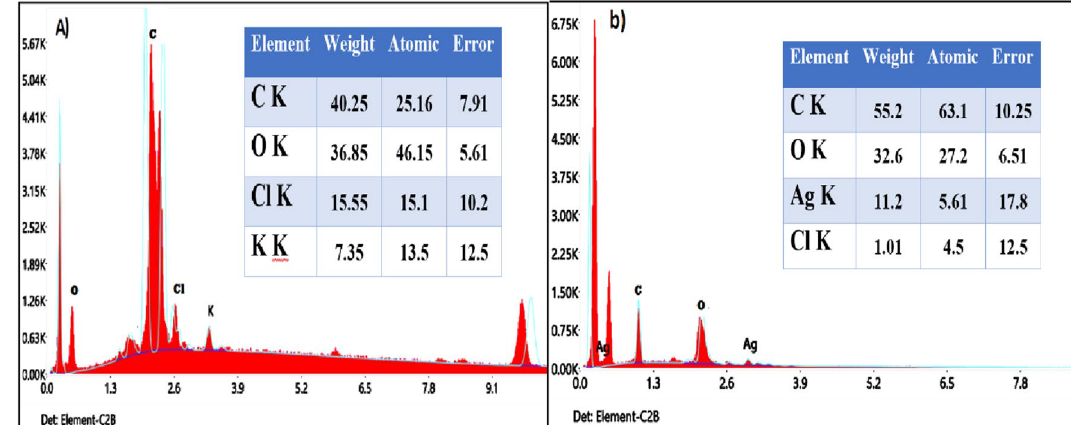
Fig.5 EDX analysis spectra of a rGO, and b rGO@Ag x %